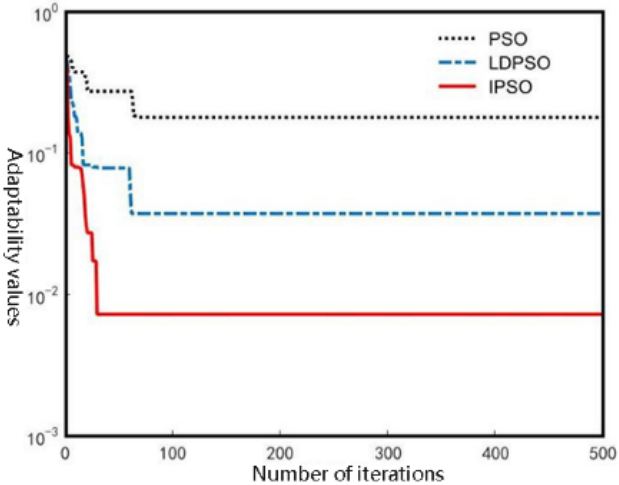
Figure 3. Convergence of Schaffer function.